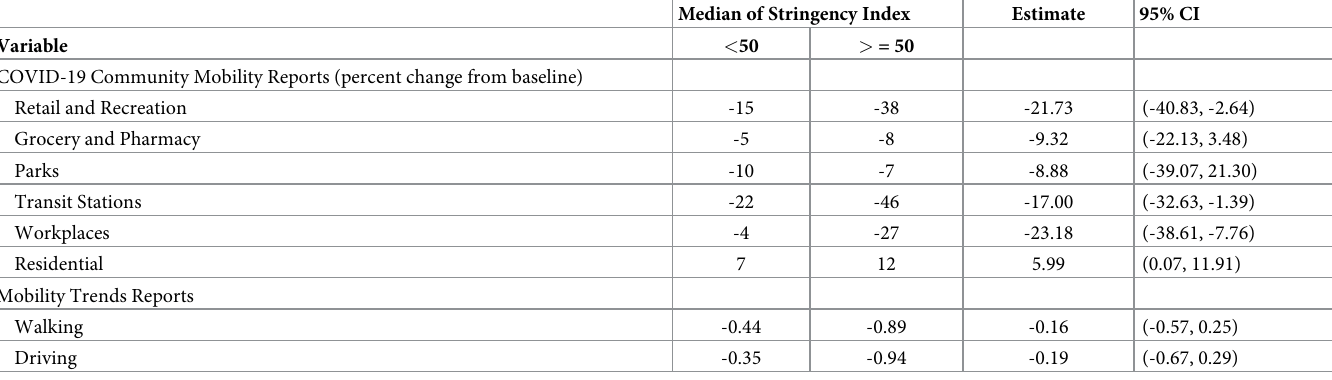
Table 2. Difference of mobility changes in the countries with high or low stringency index.